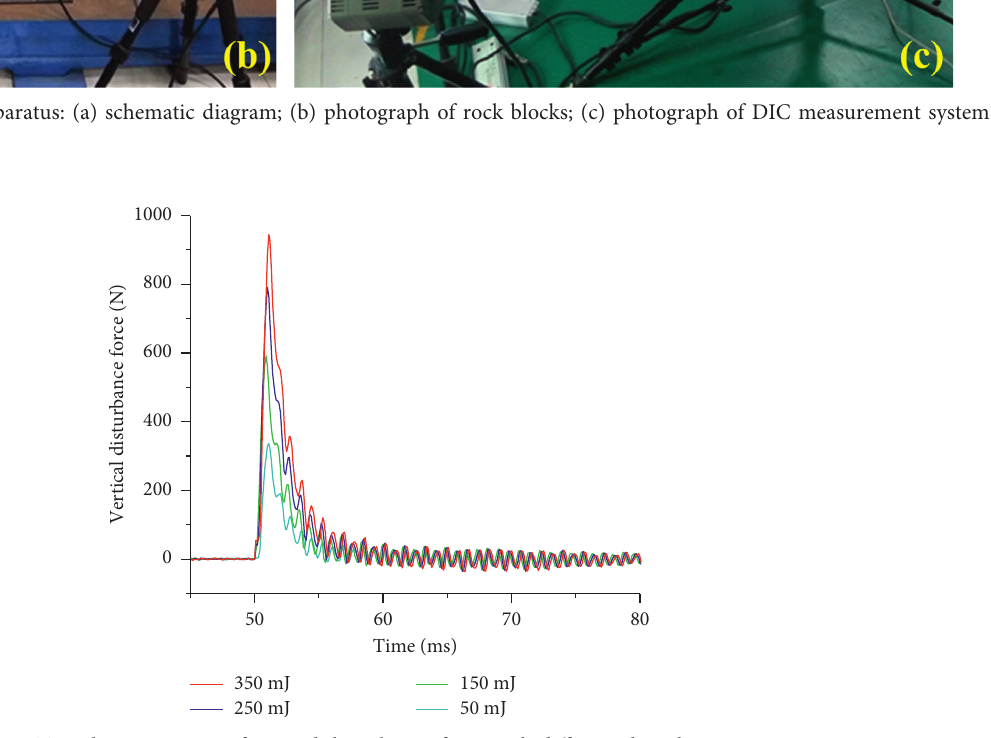
Figure 3: Time-history curves of vertical disturbance force with different disturbance